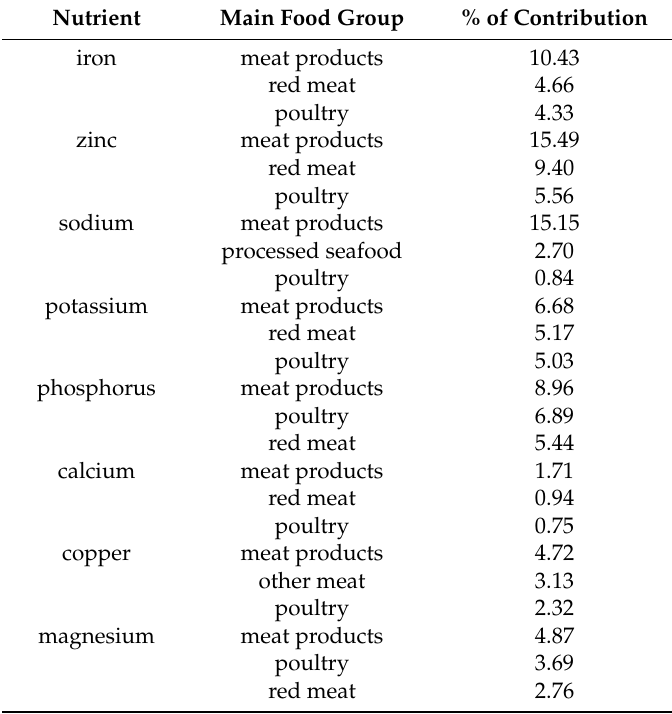
Table 6. Main food groups as the sources of iron, zinc, sodium, phosphorus, calcium, copper and magnesium contribution in the average Polish